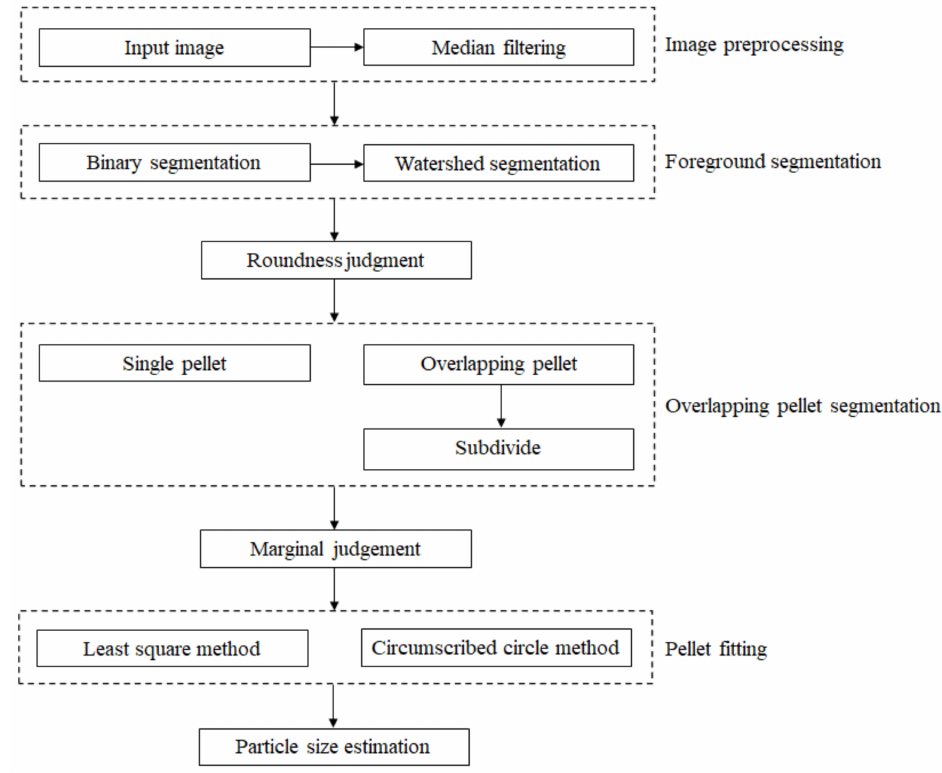
Figure 2. Flow chart of the pellet size detection